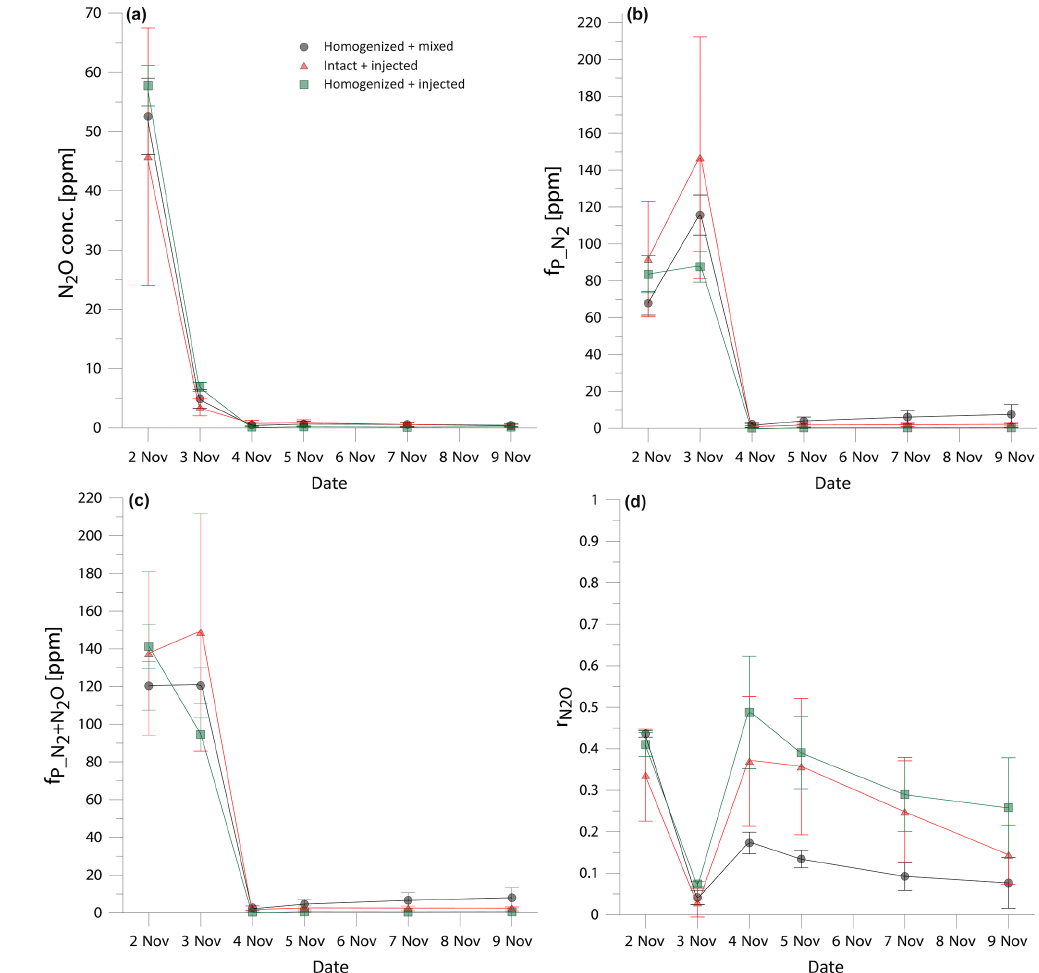
Figure 1. Comparison of the temporal changes in N 2 O concentration (a) , fraction of 15 N-pool-derived N 2 (b) , fraction of 15 N-pool-derived denitrification products (N 2 + N 2 O) (c) , and N 2 O residual fraction (d) in three treatments: homogenized soil mixed with fertilizer (black dots), intact soil cores with fertilizer added through needle injection (red triangles), and homogenized soil with fertilizer added through needle injection (green squares). Error bars represent the standard deviation of four replicates within one